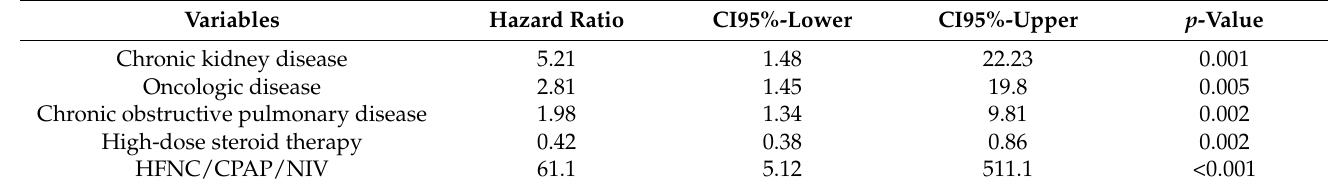
Table 6. Cox regression analysis of risk factors associated with 30-day mortality in all study populations. Variables Hazard